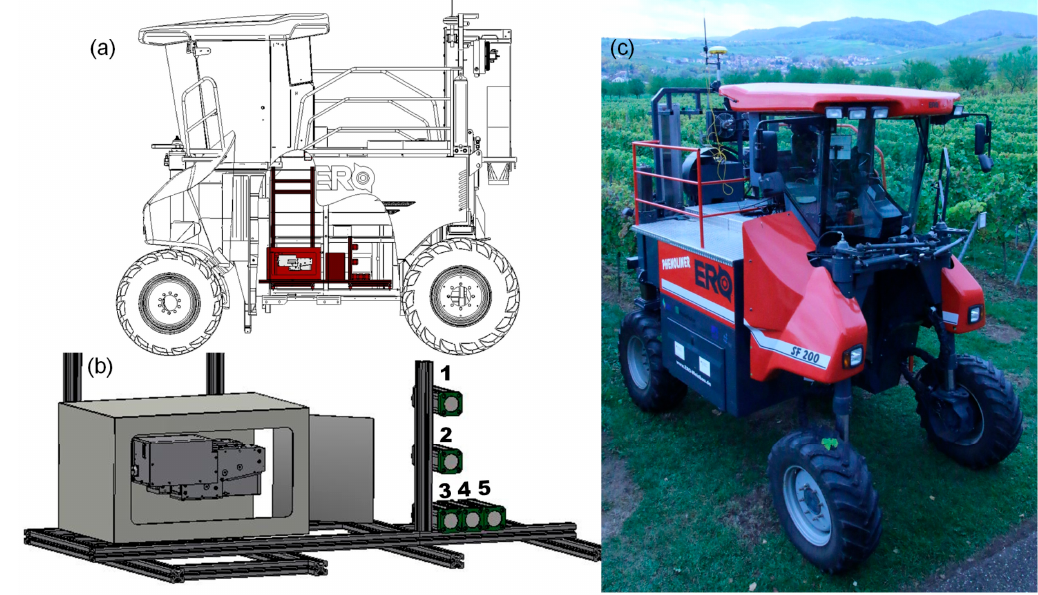
Figure 1. Overview of the Phenoliner. ( a ) Phenoliner construction plan. ( b ) Scheme of the sensor layout in the tunnel (marked red above); right: Sensor A: consisting of RGB cameras 1–3 and 5, and a NIR camera 4, left: Sensor B consisting of two hyperspectral cameras; ( c ) Phenoliner in the vine row.